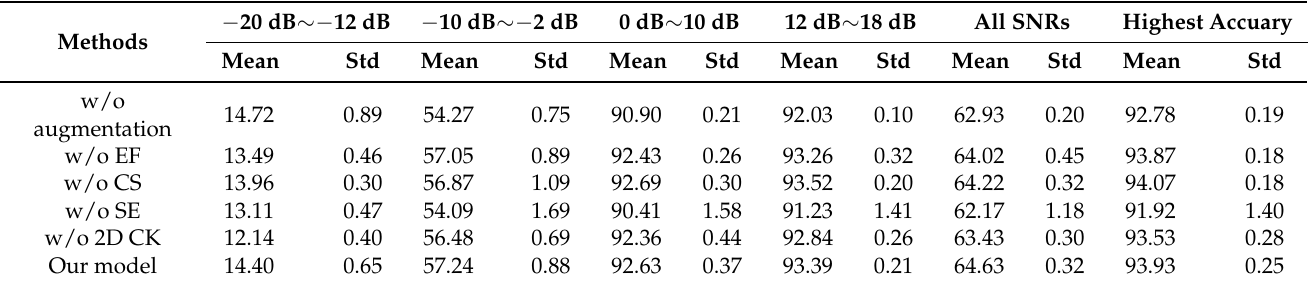
Table 8. Ablation study of different modules in LENet-M on the 2016A dataset. EF stands for expert feature branch. CS is the channel shuffle module. SE is the squeeze-and-excitation attention mechanism. 2D CK is the ks × 2 two-dimensional convolution kernel.